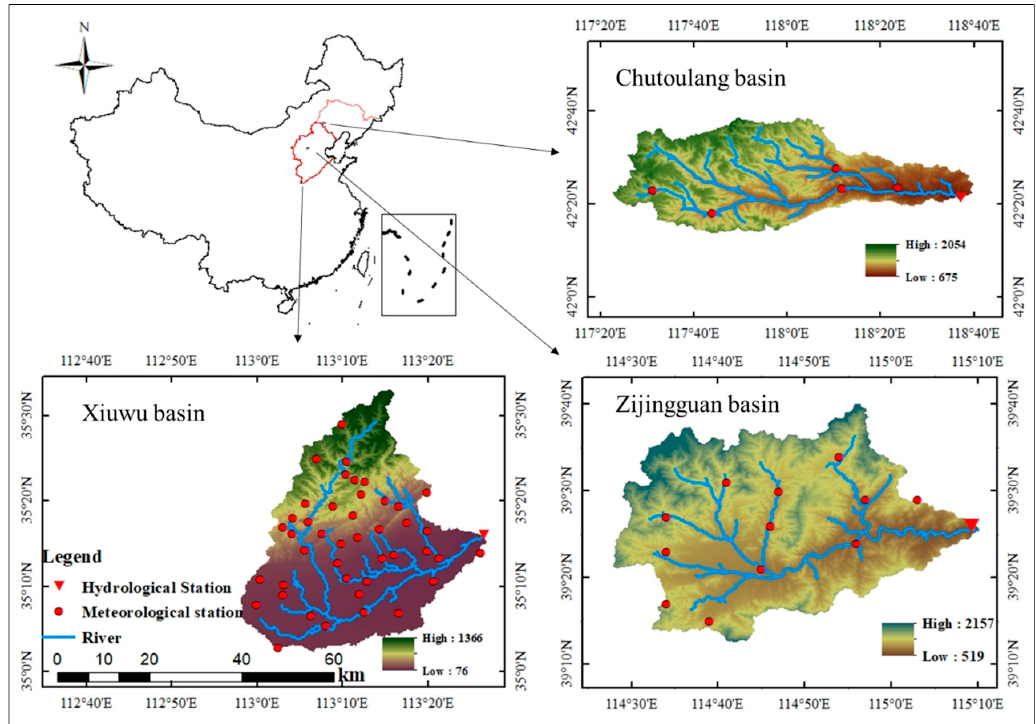
Figure 4. Map of the three basins, China.